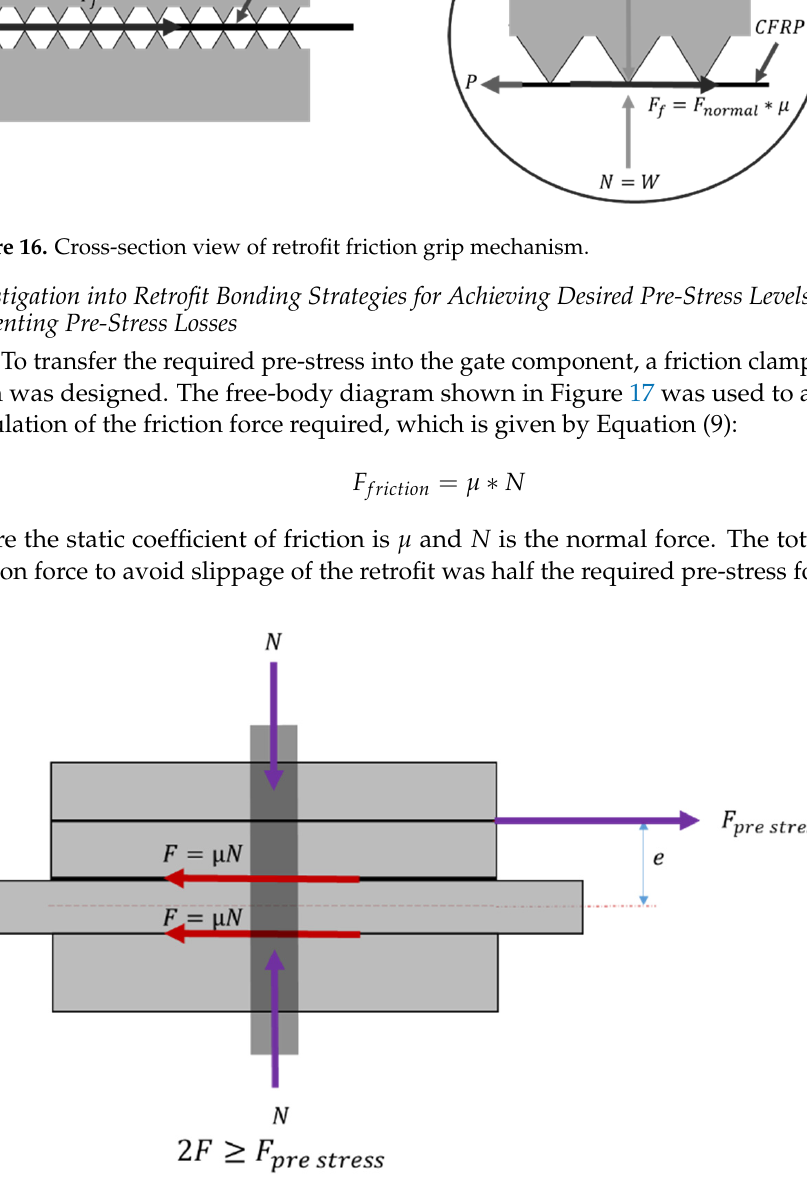
Figure 16. Cross-section view of retrofit friction grip mechanism.